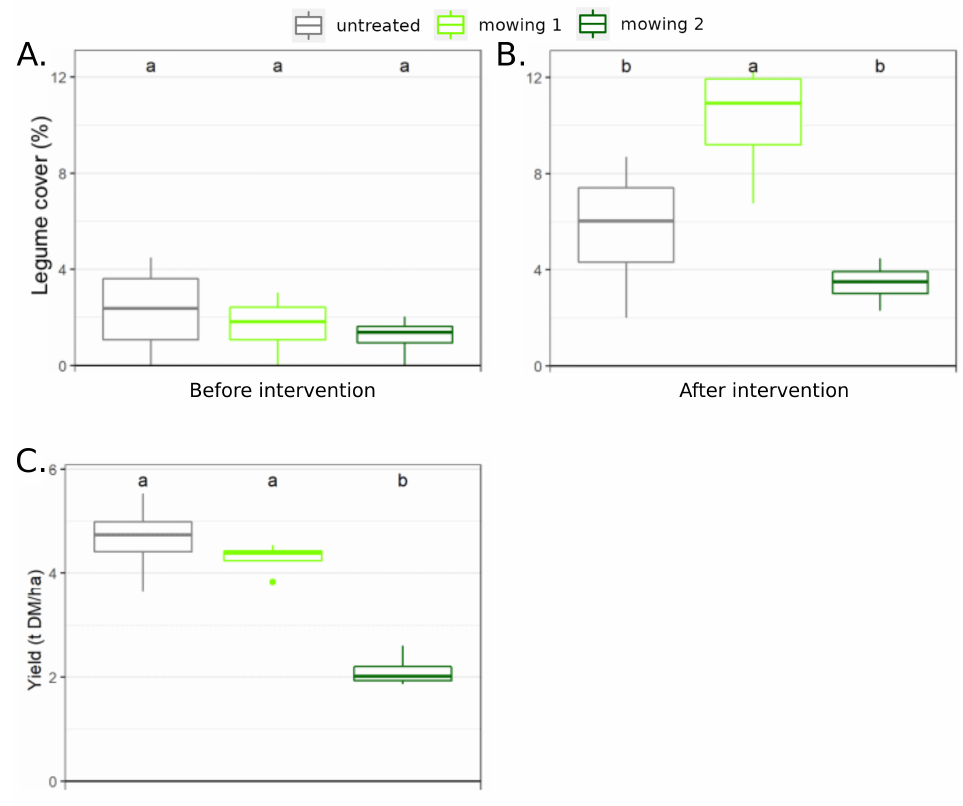
Figure 5. Experiment 2: legume cover before ( A ) and after ( B ) different mowing dates which was significantly different for mowing 1 ( p < 0.01). ( C ) Harvest yield of the pasture for the different mowing dates which was significantly lower in the mowing 2 condition ( p < 0.001). Letters indicate results of the Tukey